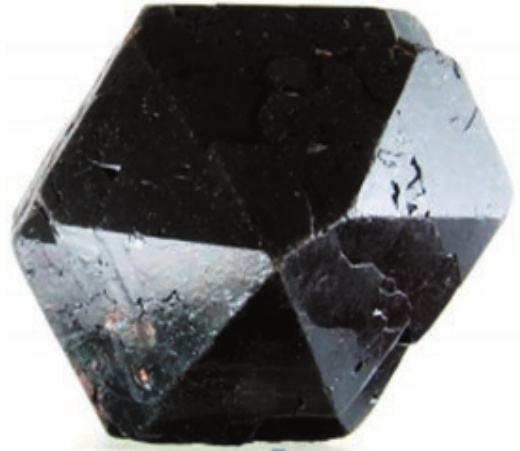
Fig. 9. Smoky quartz viewed perpendicular to the vertical axis (htt- ps://www.spiriferminerals.com/mini.php?id=2654&width=300&fi le